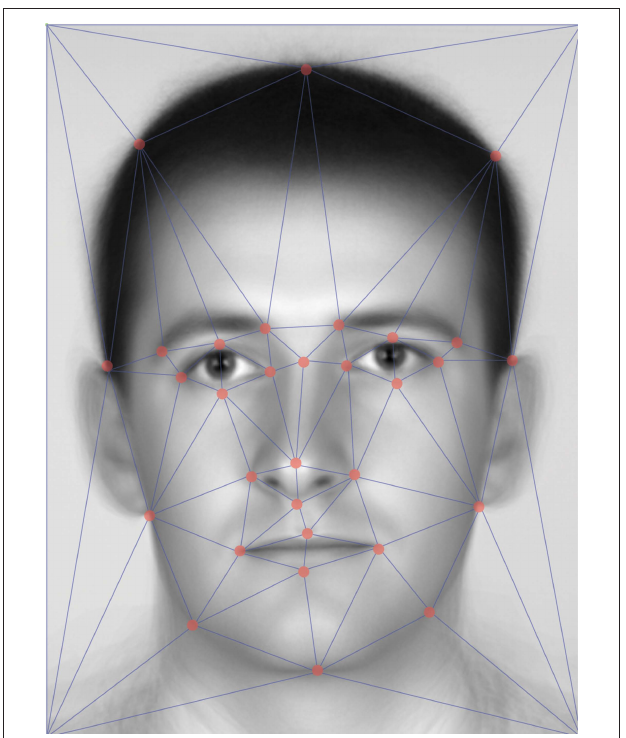
Figure 3 | The location of the 31 key-points used for morphing is superimposed on an example “morphed-average” faces from our